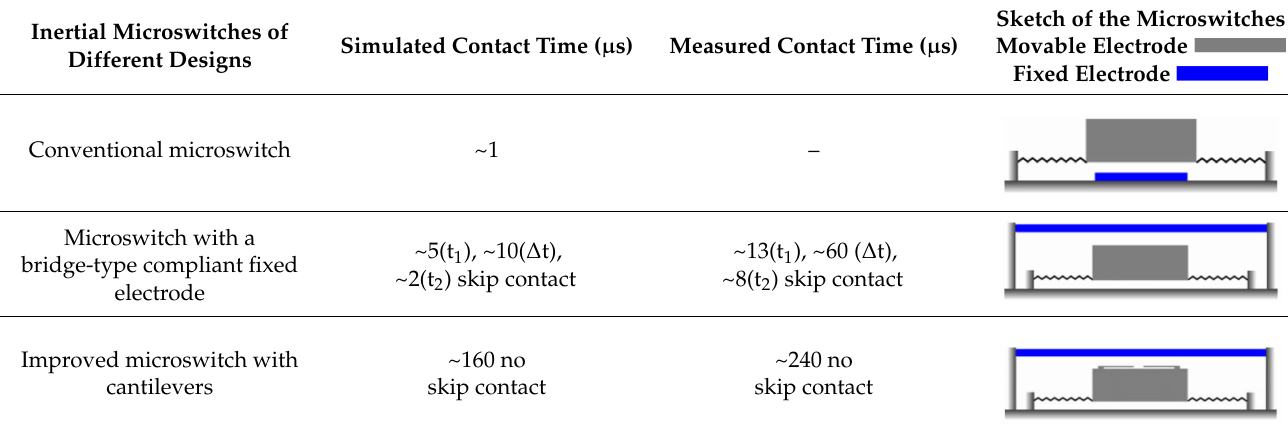
Table 3. Comparison of the contact time of inertial microswitches from different designs.